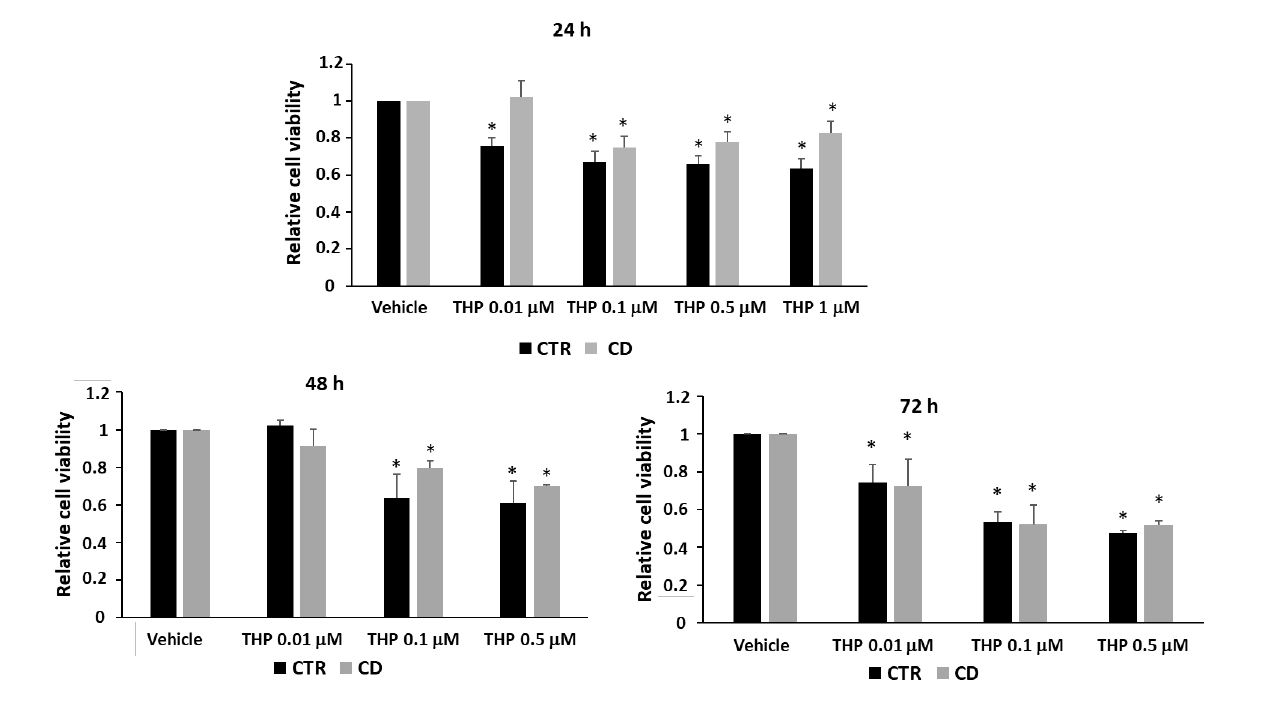
Figure 1. Relative cell viability measured by an MTT assay after treatments with THP ranging from 0.01 to 1 µM (for 24 h) or from 0.01 to 0.5 µM (for 48 and 72 h). Basal viability is measured in the presence of the vehicle (DMSO 0.05%). In all experiments, the vehicle reduced cell viability by no more than 10 – 15%. Data are reported as means ± standard error (SE) from two independent exper- iments, each performed in triplicate, on three non-CD cultures and three CD cultures. * p < 0.05 versus the respective vehicle.